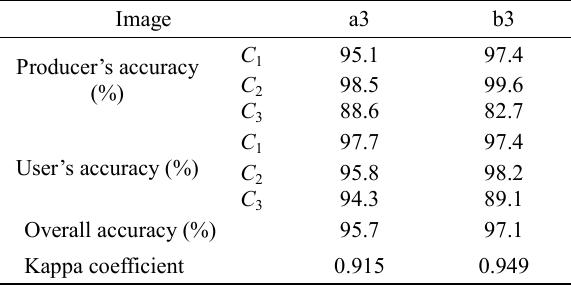
Table 1. Quantitative evaluation